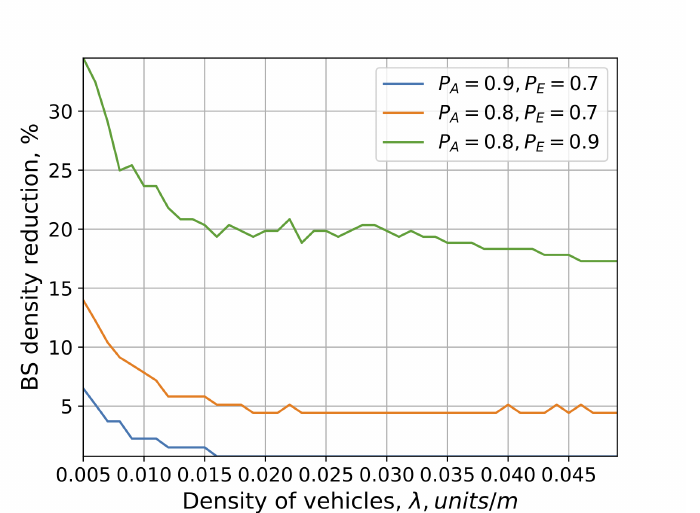
Figure 11. Gains in the required BS density as compared to the baseline BS-only